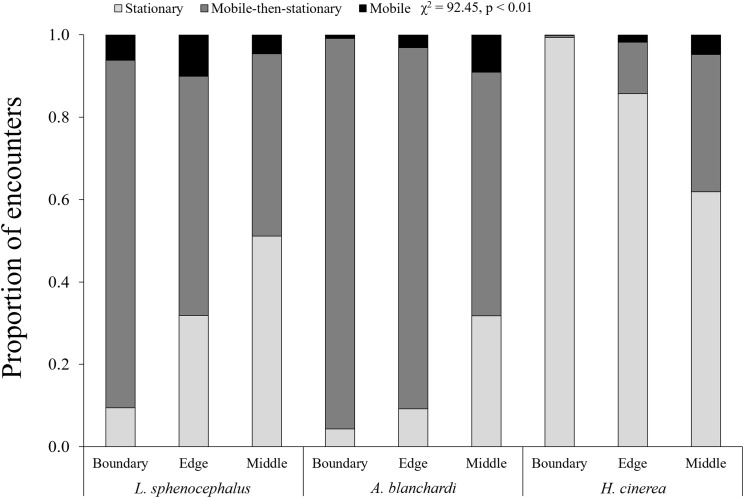
Spatial patterns in frog behavior.Proportion of encounters among study species in transect sections that remained stationary (S; light gray), mobile-then-stationary (MS; dark gray), and mobile (M; black) among southern leopard frogs (L. sphenocephalus), Blanchard’s cricket frogs (A. blanchardi), and green tree frogs (H. cinerea).